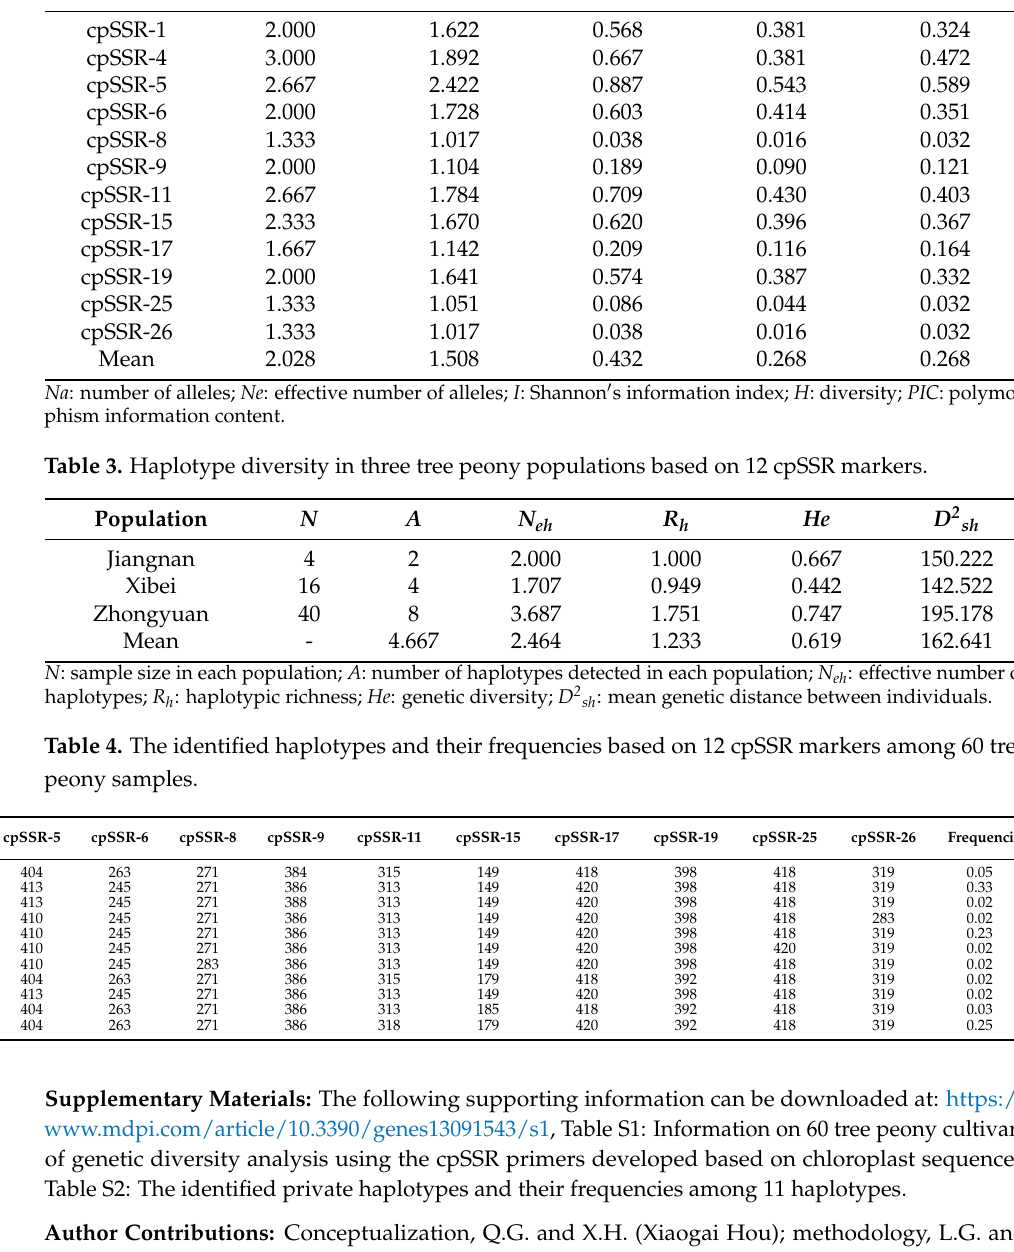
Table 2. Genetic diversity indicators for the 12 chloroplast SSR markers. Marker